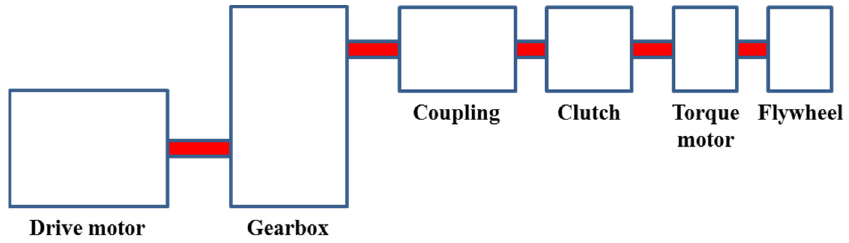
Figure 2. Layout diagram of the clutch comprehensive test bench.